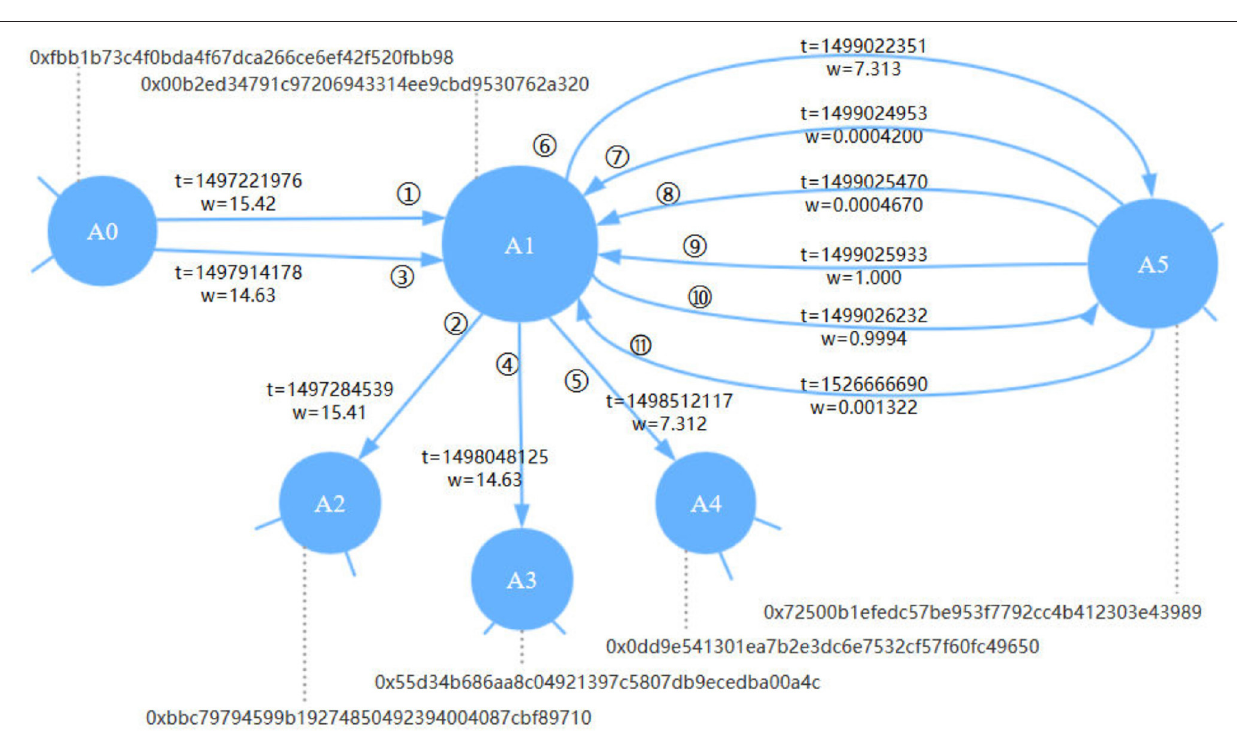
FIGURE 2 | Schematic of the Ethereum transaction network. Each node represents an Ethereum account. Each edge represents a transaction, with a timestamp t and amount value w (in Ether ) attached to it and indexed in increasing order of t . an improved network embedding algorithm based on a random walk. We now define the specific problem as